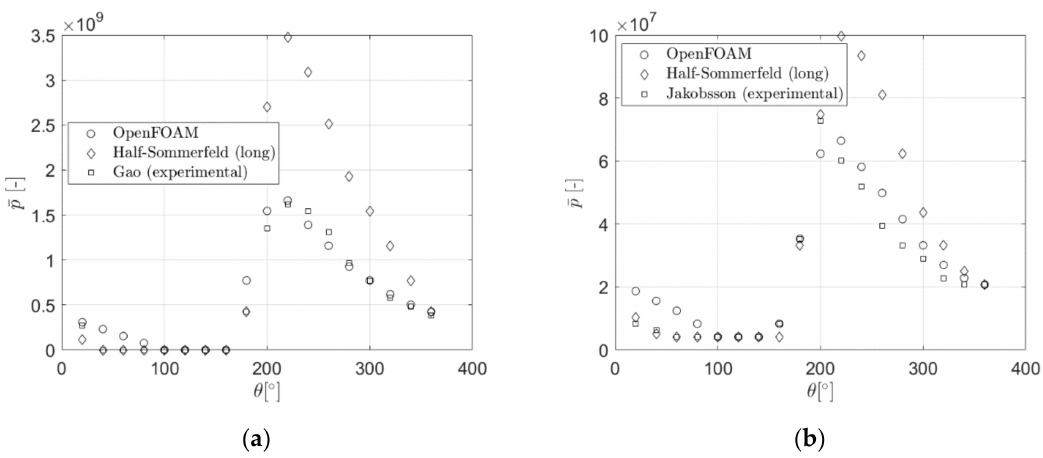
Figure 3. Validation of the present approach based on the Kunz (OpenFOAM) model by comparison with experimental data from Gao [3] ( a ), and from Jakobsson [4] ( b ) ( p = p